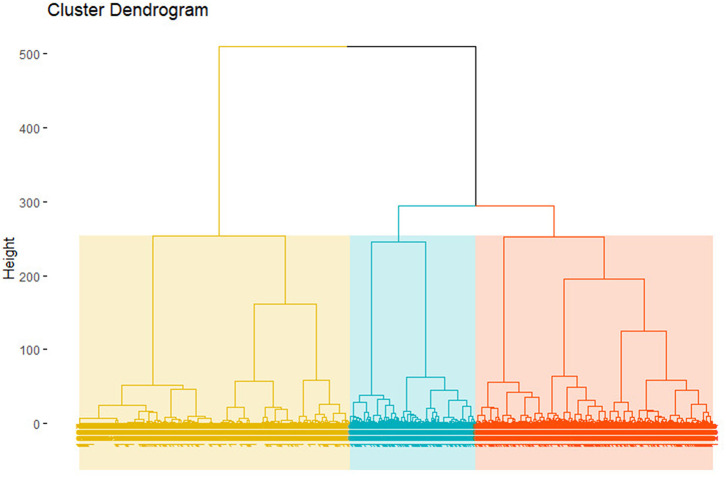
Cluster dendrogram.